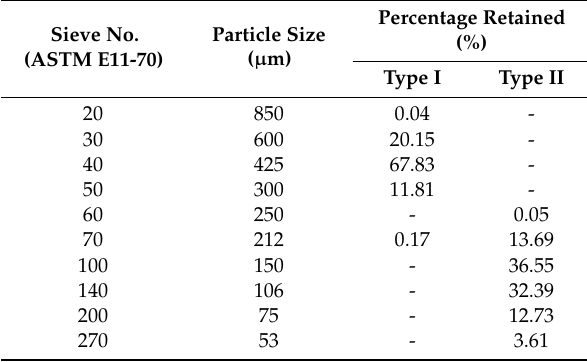
Table 2. Particle size distribution of fine